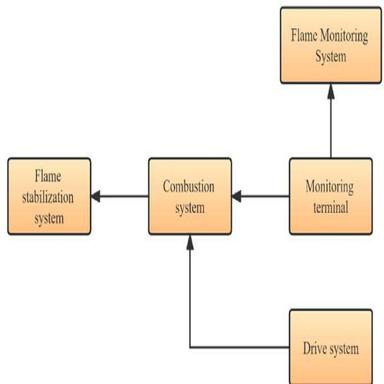
Burner system diagram.